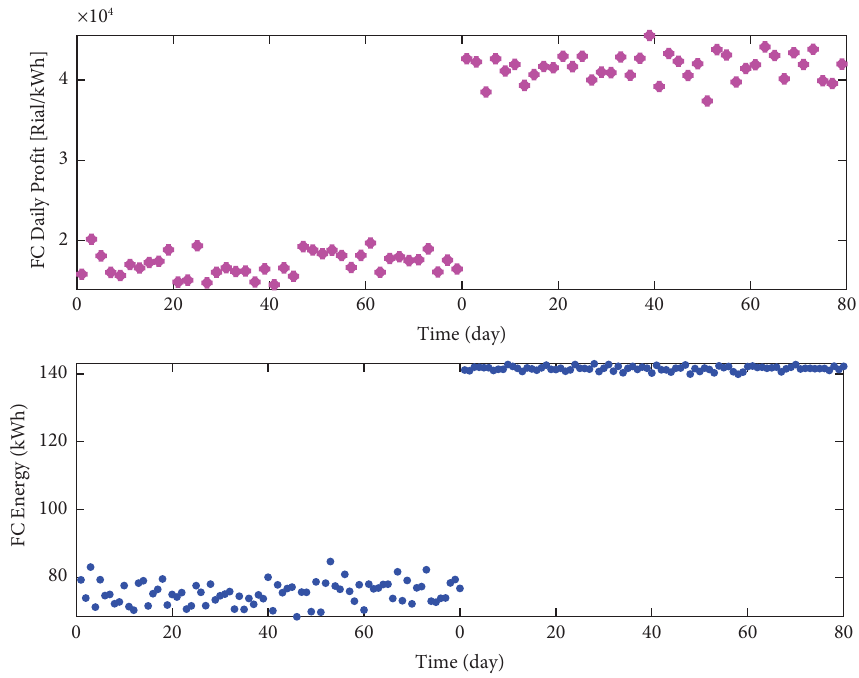
Figure 7: Average daily proft and output power of fuel cell.